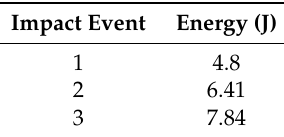
Table 2. Multiple impact events on the DuraAct